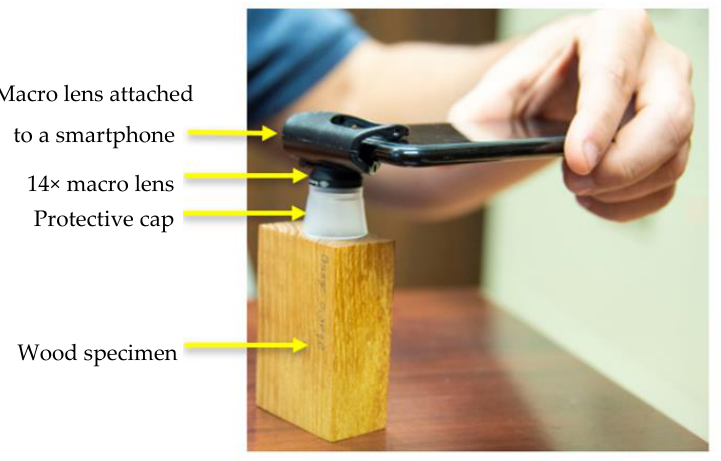
Figure 2. Image acquisition setup.